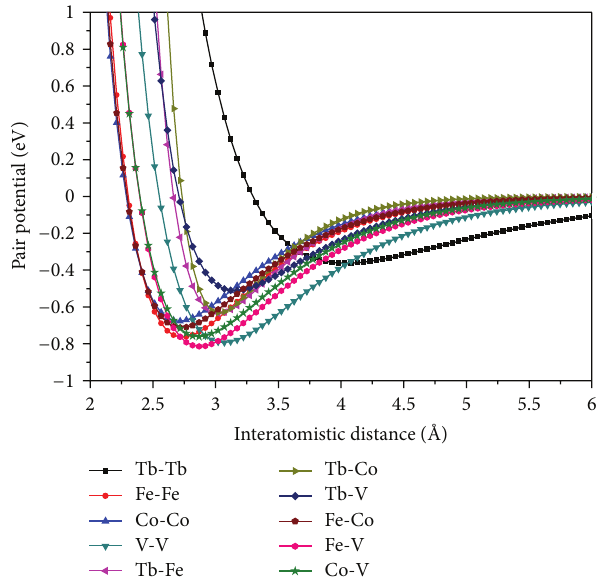
Figure 1: Potentials in the system of